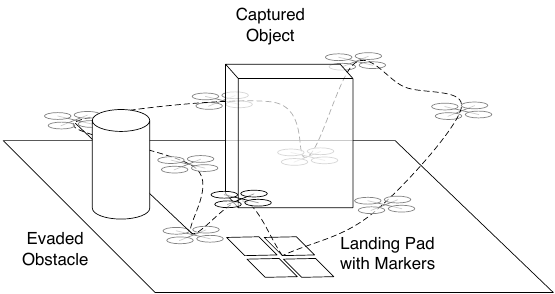
Figure 3: Concept showing MAV performing a semi-autonomous capture flight with user-defined trajectory, starting / landing aids and autonomous obstacle avoidance during